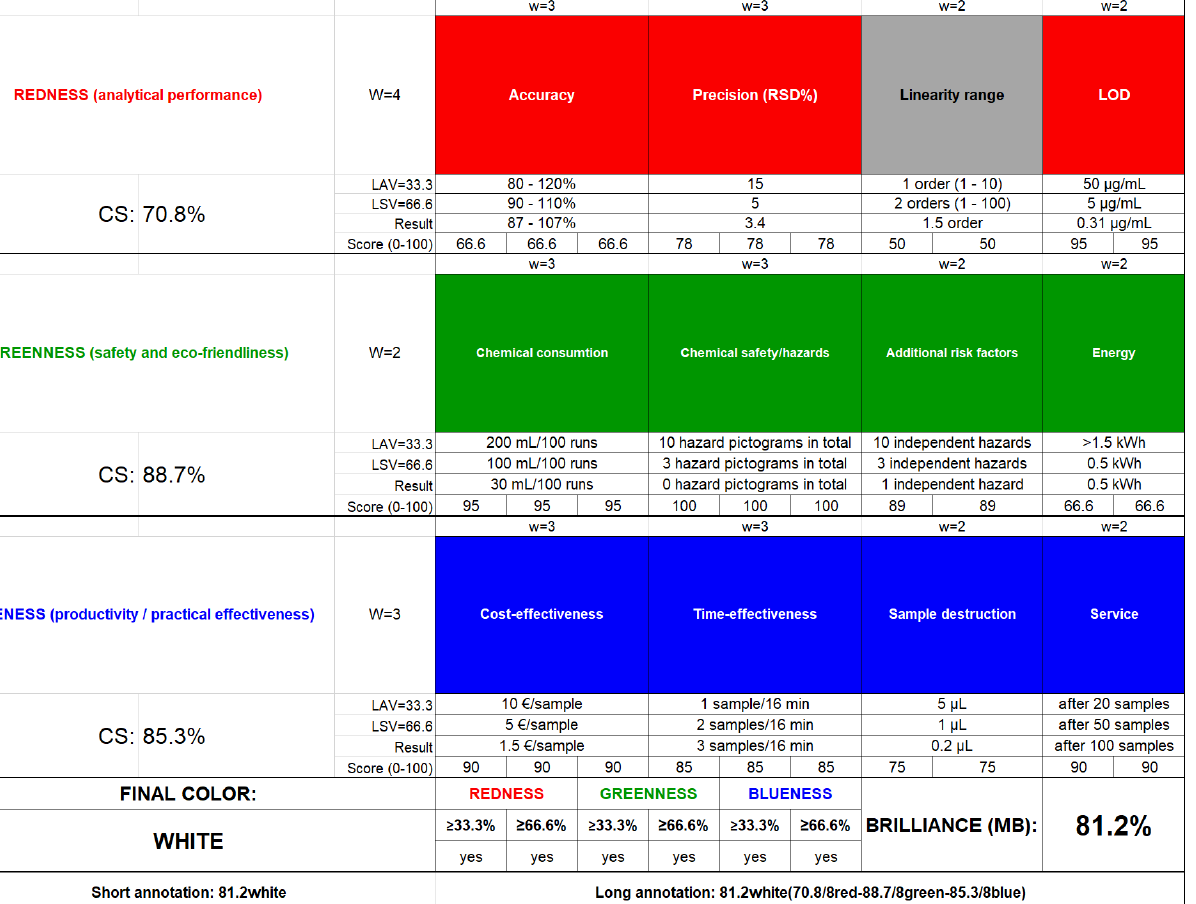
Figure 4. Evaluation of the developed CZE-UV method with repeated injection for determination of ibuprofen according to the RGB Additive Color Model.